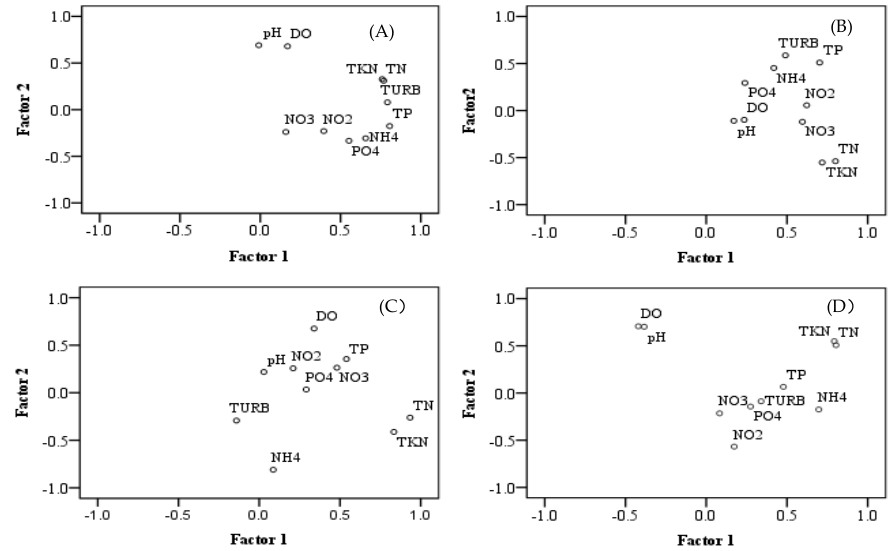
Figure 6. Factor loadings for the first factor (Factor 1) and the second factor (Factor 2). ( A – D ) indicate S12A, S12D, S332, and S18C respectively.